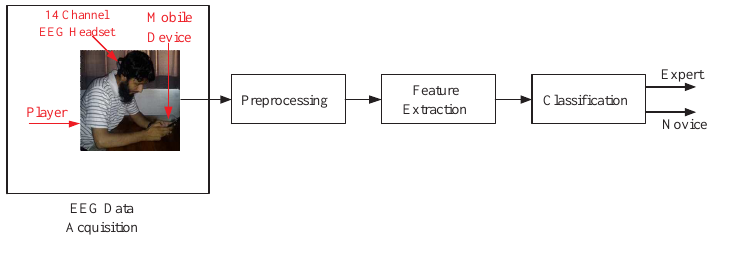
Figure 1. Block diagram of various processing steps used in this study for the purpose of expert-novice classification of game players on a consumer gaming machine using electroencephalography